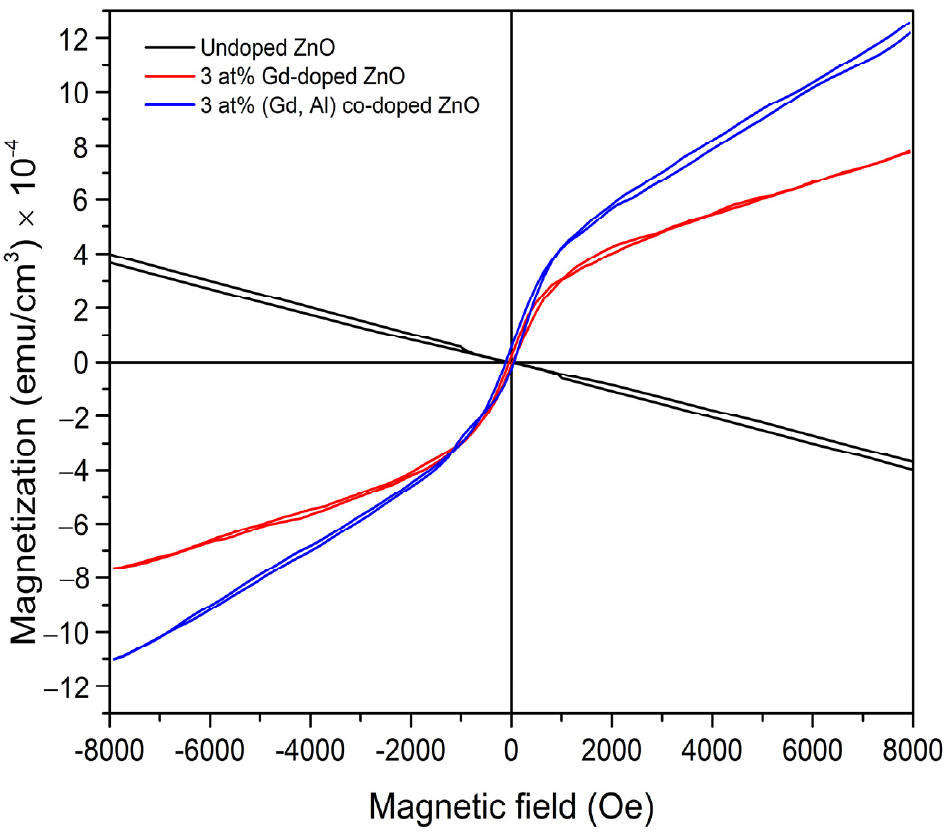
Figure 10. M-H curves of undoped ZnO, 3 at% Gd-doped ZnO, and 3 at% (Gd, Al) co-doped Figure 10. M ‐ H curves of undoped ZnO, 3 at% Gd ‐ doped ZnO, and 3 at% (Gd, Al) co ‐ doped ZnO.